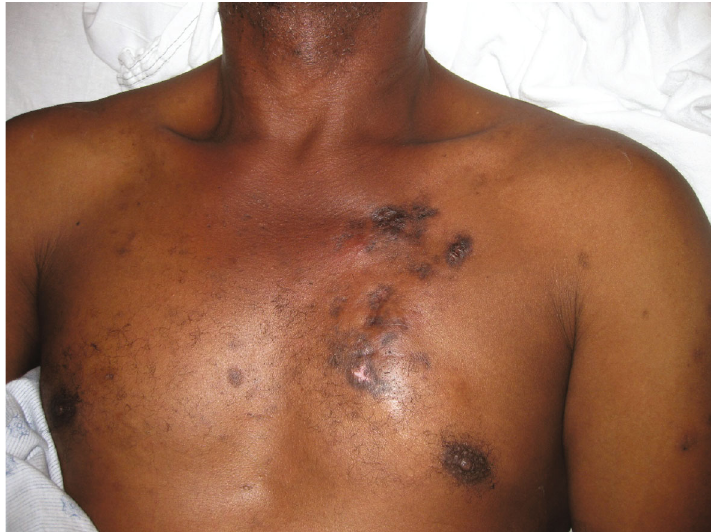
Figure 8: Multiple tender, indurated hyperpigmented plaques a ff ecting the left chest in this patient with lupus panniculitis.